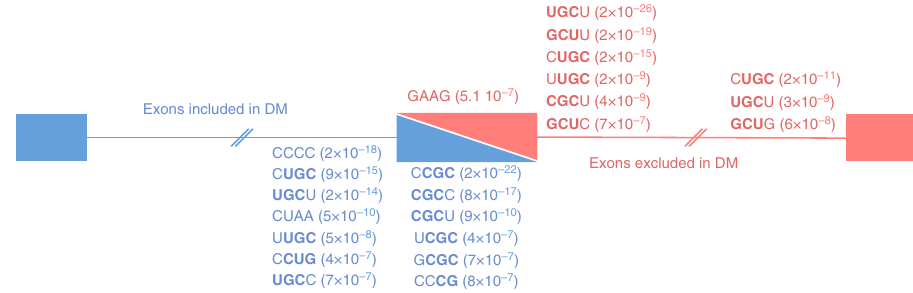
Figure 2 | MBNL-binding motifs are enriched in vicinity of exons misregulated in DM1. Sequence and binomial test P values of 4-mer RNA motifs enriched downstream, within and upstream of exons misregulated in DM1 heart samples. Sequences enriched in exons excluded in DM are indicated in red, while sequences enriched in exons included in DM are indicated in